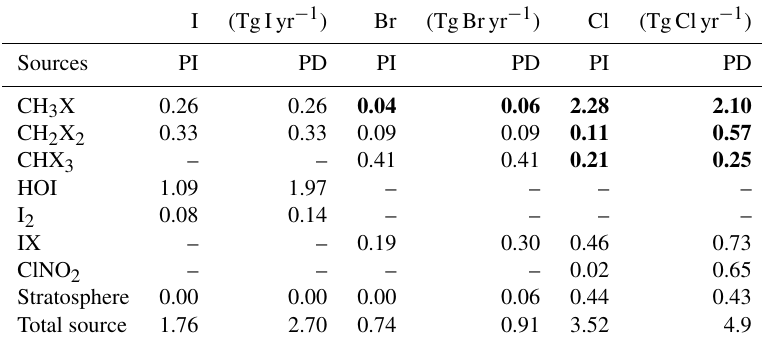
Table 1. Emission of halogen source gases for the preindustrial (PI) and present day (PD). Long-lived sources which have fixed concentrations in the model for Cl (CH 3 Cl, CH 2 Cl 2 , CHCl 3 ) and Br (CHBr 3 ) are shown in terms of chemical release (e.g. reaction with + OH, + hν , + Cl) and are in bold. I 2 and HOI are the inorganic ocean source from O 3 reacting with oceanic iodide (Carpenter et al., 2013), IX is from the uptake of iodine gases onto sea salt to release IBr or ICl, and ClNO 2 is the source from the uptake of N 2 O 5 on sea